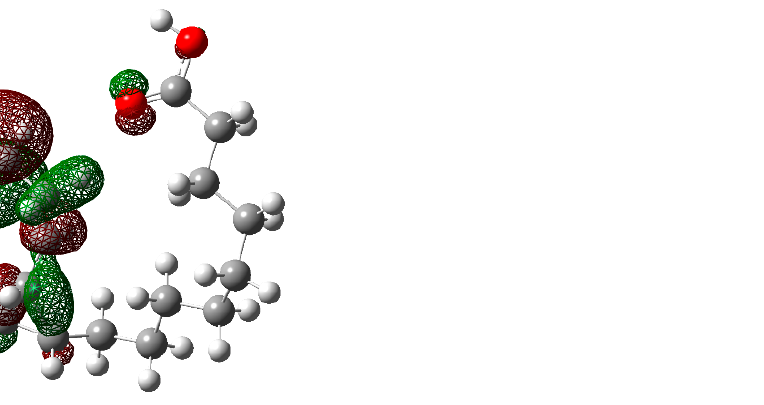
Figure 12. Graphical representation of the dual descriptors ( Δ f k , Δ S k and Δ ω k ) for the most active sites of neutral α -linoleic acid molecule.